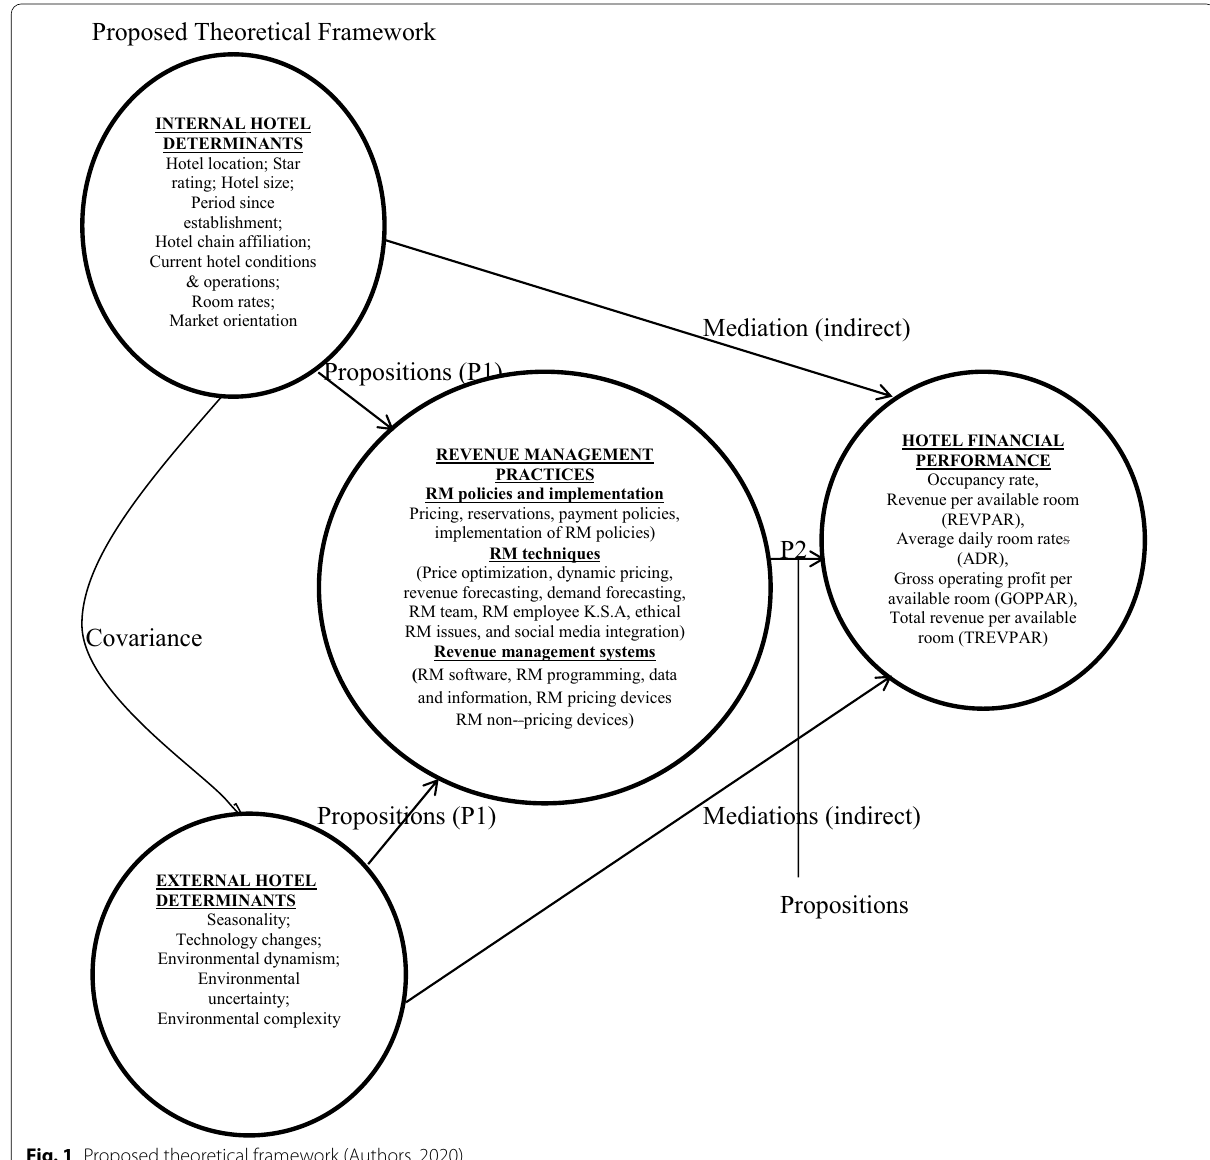
Fig. 1 Proposed theoretical framework (Authors,